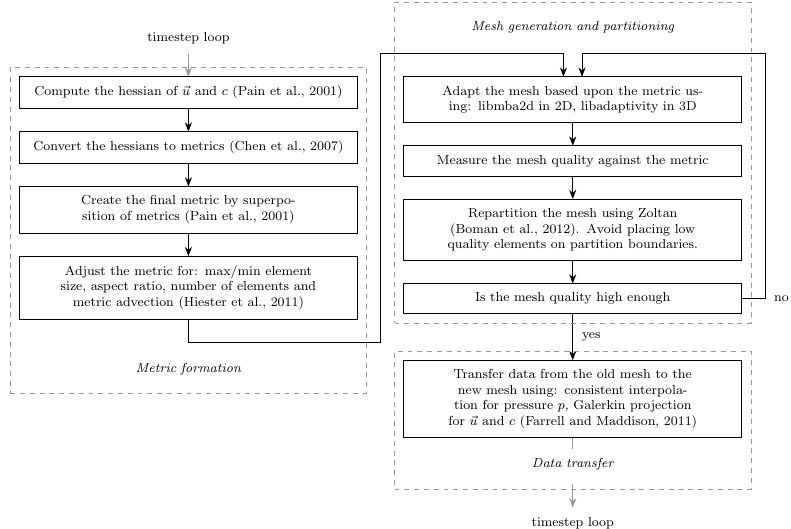
Figure 1. A description of the high-level algorithm involved in adapting the mesh. This algorithm is invoked repeatedly throughout the simulation at a fixed interval specified as a number of time